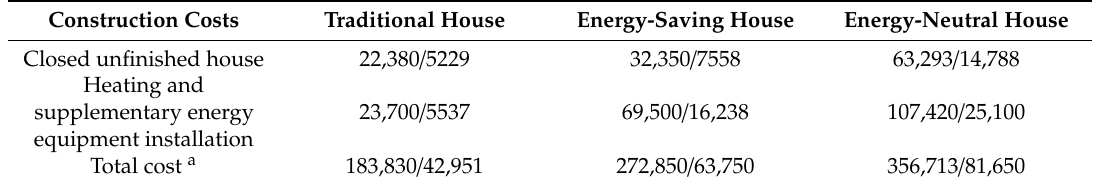
Table 2. Construction costs of a single-family house using alternative construction technologies and energy, in Polish zloty (PLN) /